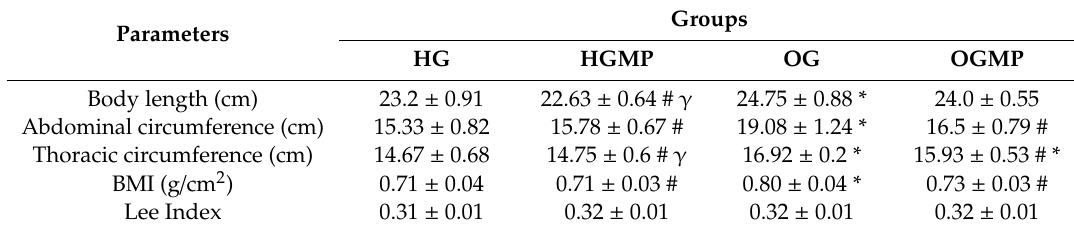
Table 2. Murinometric parameters of healthy and obese rats after MP seed extract